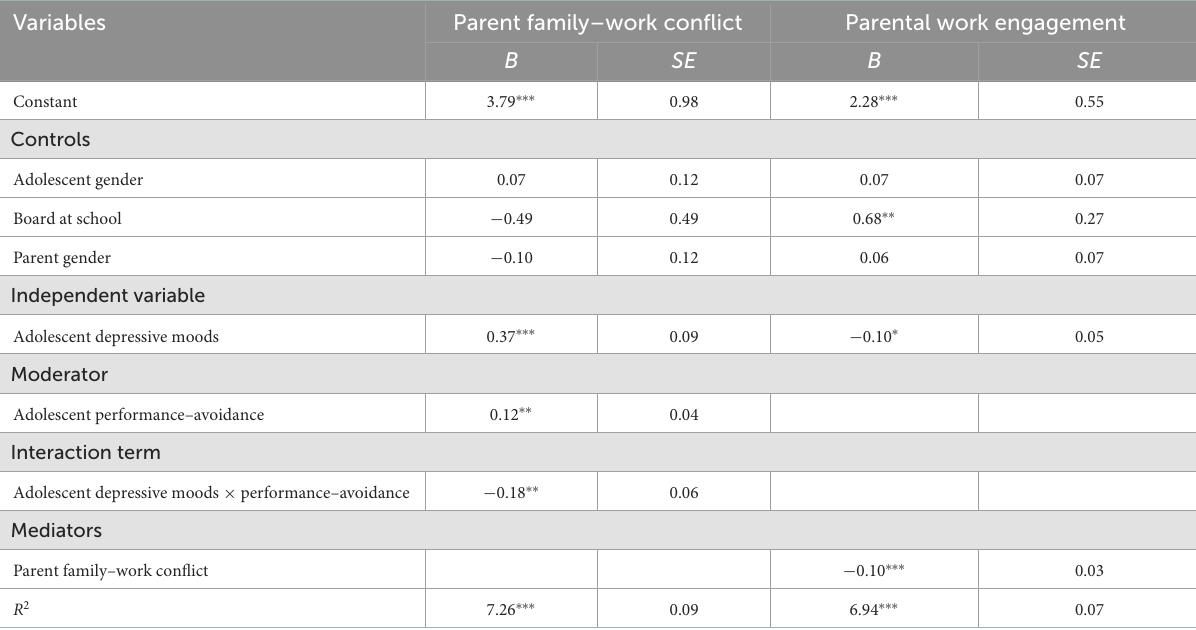
TABLE 4 Summary of regression analysis of hypotheses